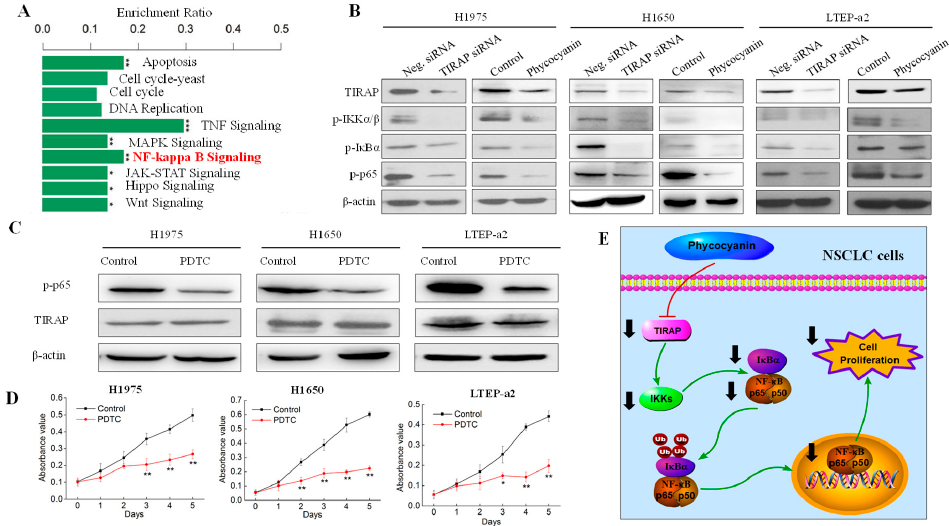
Figure 6. Phycocyanin exerted anti-proliferative effects through down-regulating TIRAP / NF- κ B activity in non-small cell lung cancer cells. ( A ) RNA-seq analysis of the potential pathways involved in phycocyanin-mediated biological process in LTEP-a2 cells. *, p < 0.05, **, p < 0.01, ***, p < 0.001. ( B ) Western blot analysis of TIRAP and NF- κ B pathway expressions in H1975, H1650, and LTEP-a2 cells after treatment with TIRAP siRNA and phycocyanin, respectively. For phycocyanin treatment, proteins were extracted after treatment with phycocyanin and control for 72 h. For siRNA transfection, cells were exposed to Neg. and TIRAP siRNA for 12 h, followed by culturing with complete medium for 48 h before protein extraction. ( C ) Western blot analysis of TIRAP and phosphorylated p65 expressions in H1975, H1650, and LTEP-a2 cells at 72 h after treatment with 10 µ M PDTC for 24 h. ( D ) Cell proliferation analysis of H1975, H1650, and LTEP-a2 cells after treatment with 10 µ M PDTC for 24 h. ( E ) Illustration of phycocyanin / TIRAP / NF- κ B regulation process in NSCLC cells. TIRAP, Toll / interleukin 1 receptor domain-containing adaptor protein. Neg. siRNA, negative control siRNA. PDTC, pyrrolidine dithiocarbamate. Bars represent mean ± SD. *, p < 0.05; **, p <